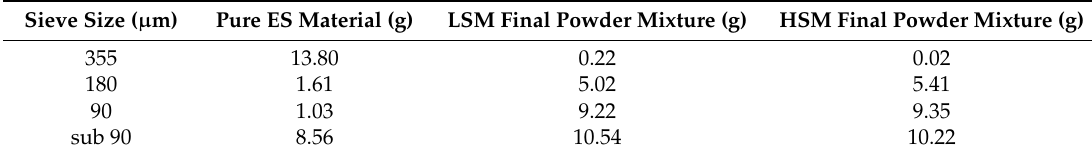
Table 5. Sieve analysis results (the mixtures contain 5% ES material).